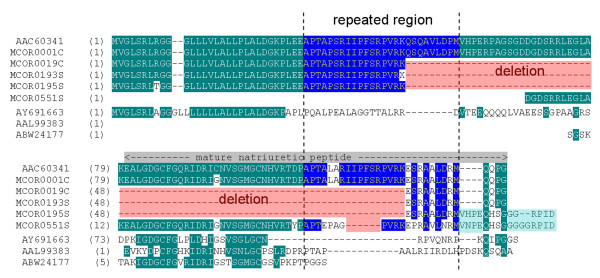
Alignment of the deduced amino acid sequence of full-length NP precursor clusters (MCORs) and other NP precursors, including the previously described M. corallinus AAC60341. A repeated region is shown between dashed bars, with the conserved residues in blue. Some "in frame" deletions and insertions, with regard to the previously described AAC60341, are shaded in red and light blue, respectively. The predicted region of mature natriuretic peptide is indicated above the alignment.